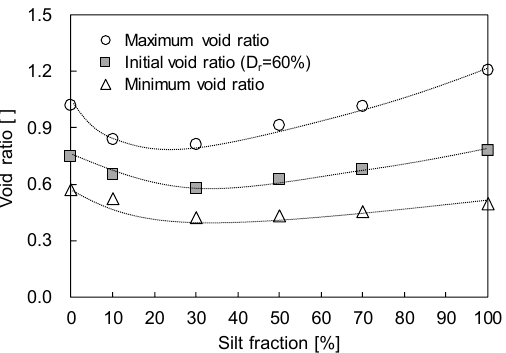
Figure 1. Maximum, minimum, and initial void ratios of sand–silt mixtures with respect to silt fraction. D r denotes the relative density of specimen.